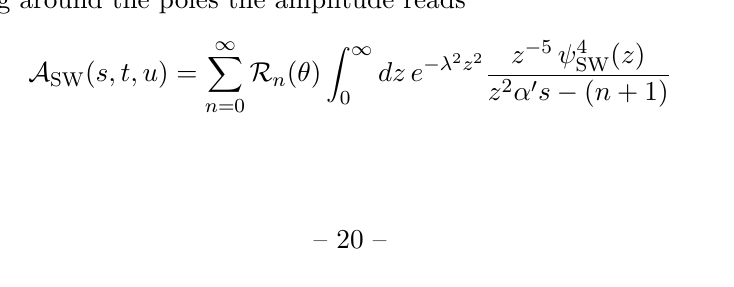
Figure 4 . Real (left) and imaginary (right) parts of the integral R z of z 0 . Red is a taking the wave function with Neumann boundary condition (maximum at z = 1 ), blue is Dirichlet, vanishing at z = 1 . The value of α 0 new poles is zero in the Dirichlet case because of the vanishing of the wave function at the wall. Contribution from poles that we have previously crossed is mostly imaginary (branch